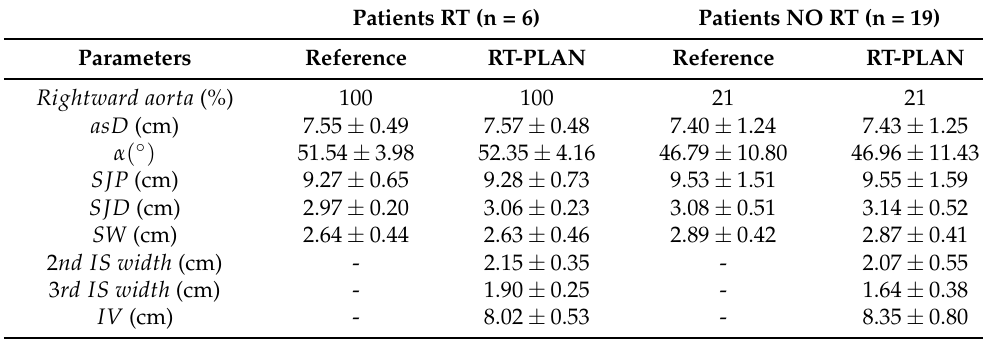
Table 2. Indices values for all parameters examined for both subjects suitable and unsuitable for RT. Patients RT (n = 6)